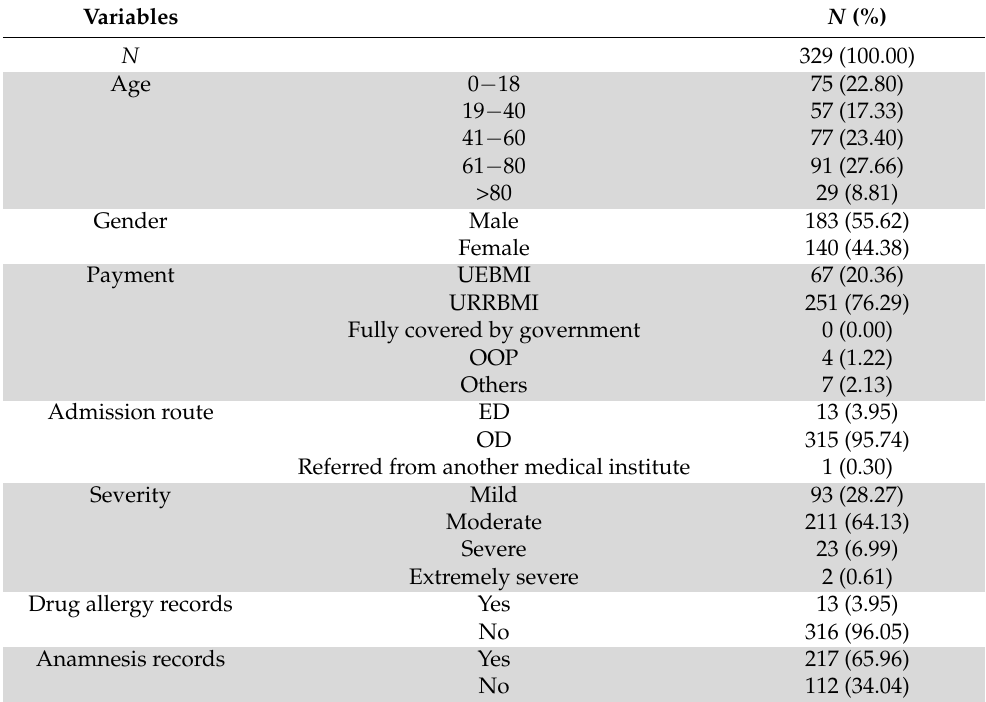
Table 5. Characteristics of the included pneumonia patients ( N = 329).